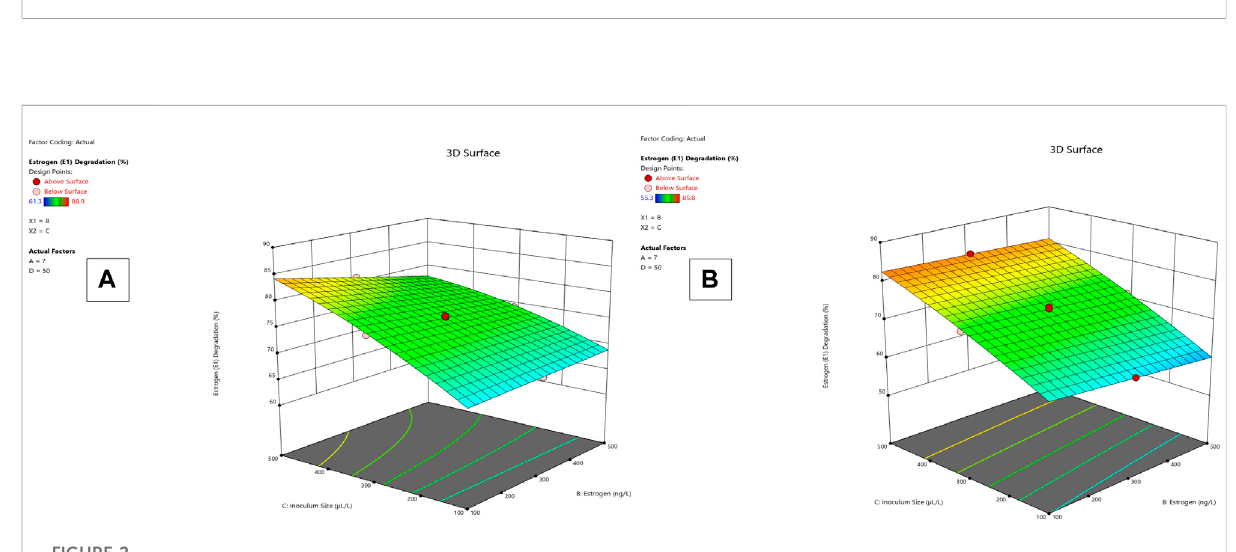
(Table 1). Conversely, Lysinibacillus.